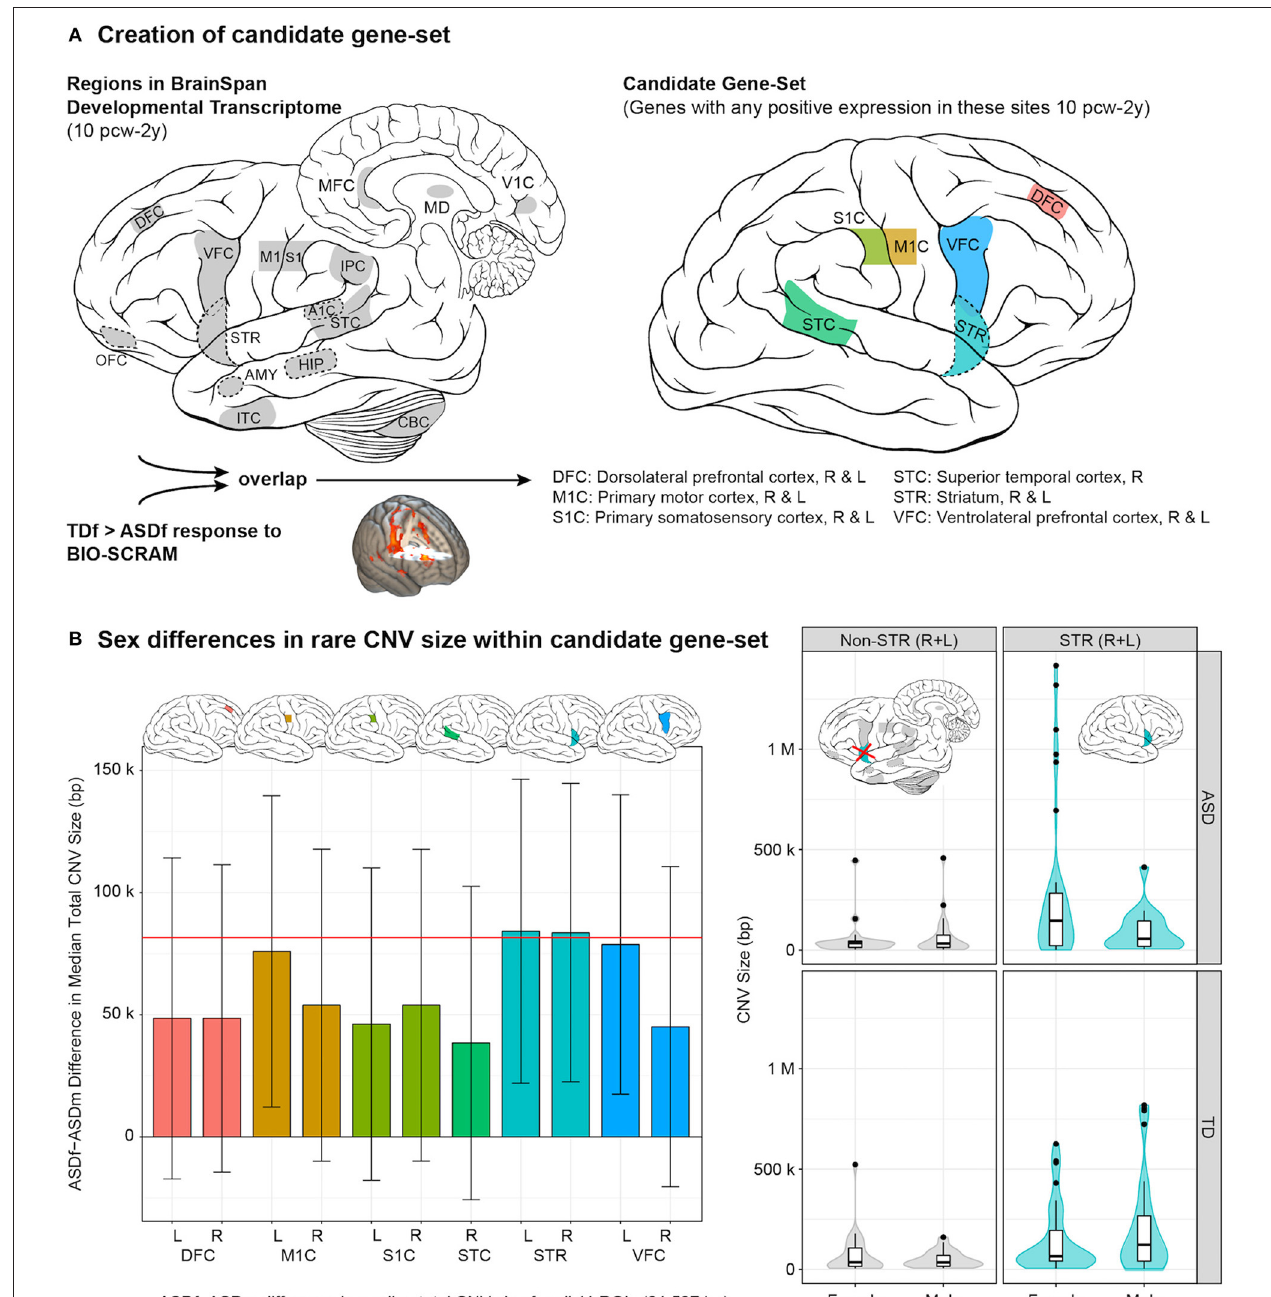
FIGURE 1 | Female autism neurogenetic profile. (A) Creation of candidate gene-set involved identifying 11 regions of interest (ROIs) that had both been characterized in the BrainSpan Developmental Transcriptome (left) and showed a significant typically-developing female > ASD female (TDf > ASDf) response to biological motion (BIO-SCRAM); genes were then identified that showed positive expression in these overlapping regions (right) between 10 post-conceptual weeks (pcw) through 2 years (y). (B) (Left) bar plot with standard errors demonstrating the sex difference (ASDf - ASDm) in median total CNV size, in base pairs (bp), within the candidate gene-set. Plots of the CNV size difference are provided for each of the 11 ROIs. (Right) distribution of size of rare CNVs containing gene(s) expressed in right (R) and left (L) striatum (STR) from 10 pcw to 2 y (right panels, cyan) by group and sex. For comparison, “non-STR (R + L)” includes rare CNVs containing gene(s) characterized in BrainSpan that were not positively expressed in R/L-STR from 10 pcw to 2 y (left panels, gray). Of note, rare CNVs often contained gene(s) that were expressed in multiple brain regions (e.g., STR plus additional ROI[s]). Violin plots depict a Gaussian kernel density estimate, and are overlaid with Tukey-style boxplots. Brain art adapted from illustrations created by Patrick Lynch and C. Carl Jaffe, commons.wikipedia.org/wiki/File:Brain_human_lateral_view.svg and Brain_human_sagittal_section.svg, licensed under a Creative Commons Attribution 2.5 Generic License, 2006. Figure constructed by Allison Jack PhD and reprinted with permission from Jack et al.